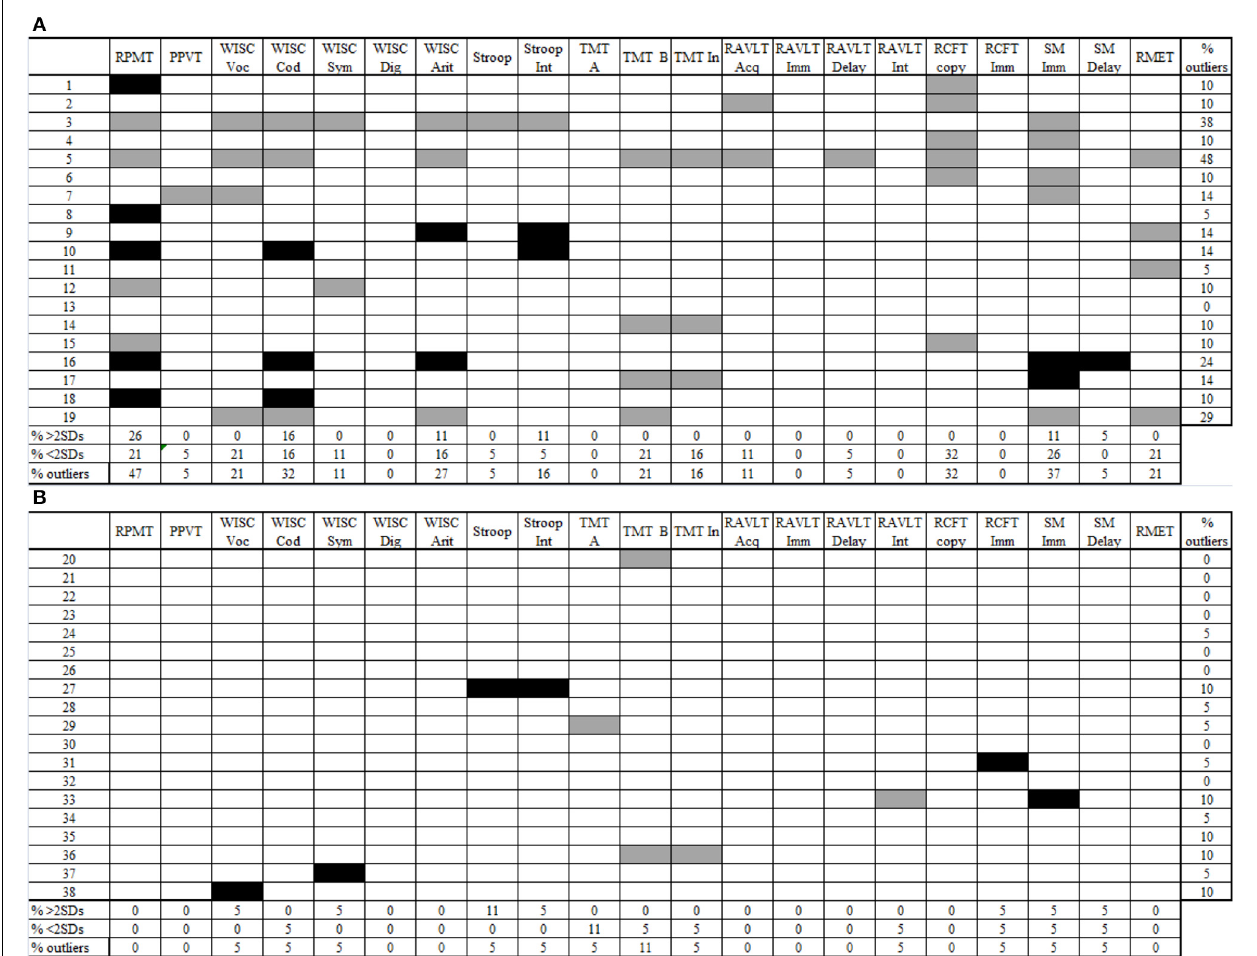
FIGURE 2 | Individual profiles of performance for AS children (2A) and controls (2B). Gray cells show performance 2 SDs below the control mean (sub-normal). Black cells show performance 2 SDs above the control mean (supra-normal). Blank cells show performance between − 1.99 and 1.99 SDs according to the control mean (normal performance). RPMT, Raven’s Progressive Matrices Task; PPVT, Peabody Picture Vocabulary Test; WISC voc, Wechsler Intelligence Scale for Children vocabulary subtest; WISC cod, Wechsler Intelligence Scale for Children coding subtest; Wechsler Intelligence Scale for Children symbol search subtest; Wechsler Intelligence Scale for Children digit span subtest; Wechsler Intelligence